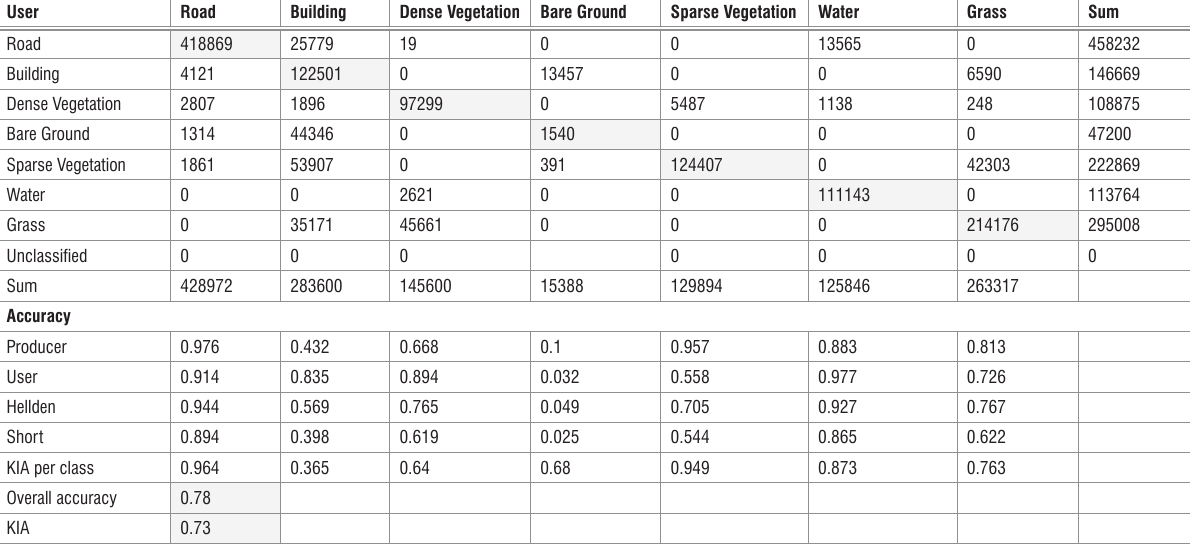
Table 2: Error matrix based on training and test areas mask using spectral